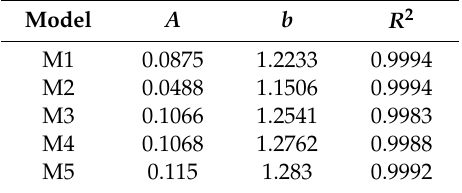
Table 5. Parameters of the regression analysis for unit discharges.